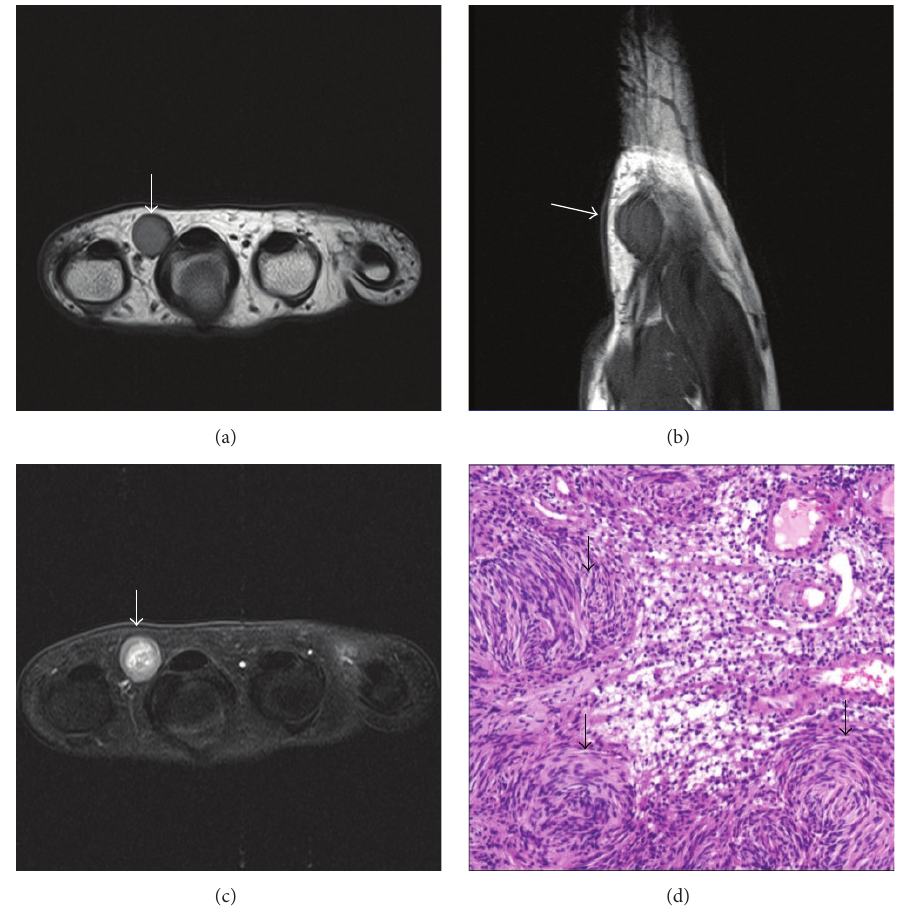
Figure7:Schwannoma.MRI(ofthesamepatientasinFigure 6)showsawell-definedT1W((a),(b))hypointenseandT2WFS(c)hyperintense lesion in 2nd-3rd web space (arrows). Underlying bone shows normal cortical outline. Microphotograph (d) shows hypocellular and hypercellular areas with vessels showing perivascular hyalinization (arrows). H&E ×